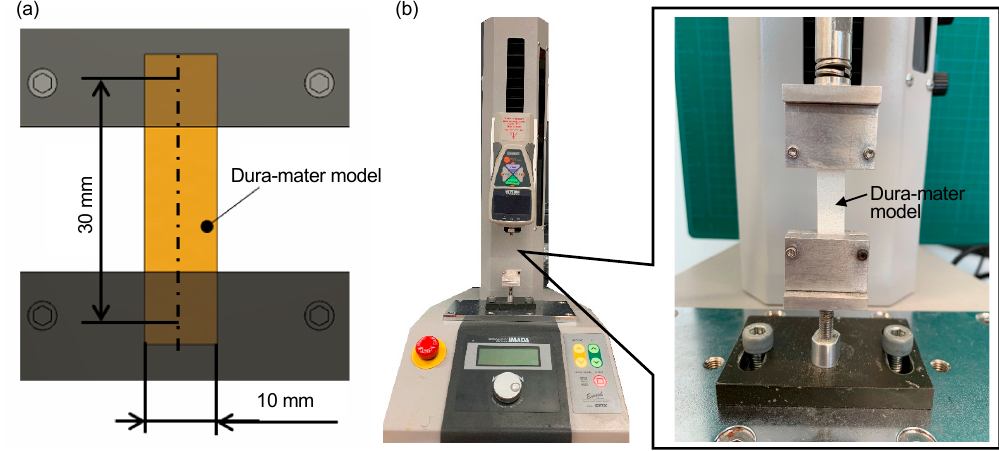
Figure 7. Tensile test: ( a ) Sample size for the tensile test; ( b ) Measurement setup for the tensile test of dura-mater